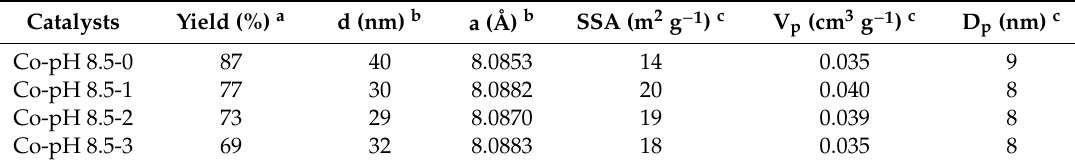
Table 3. Product yields, crystalline sizes, lattice constants and textural of cobalt oxides prepared at pH 8.5 with di ff erent number of